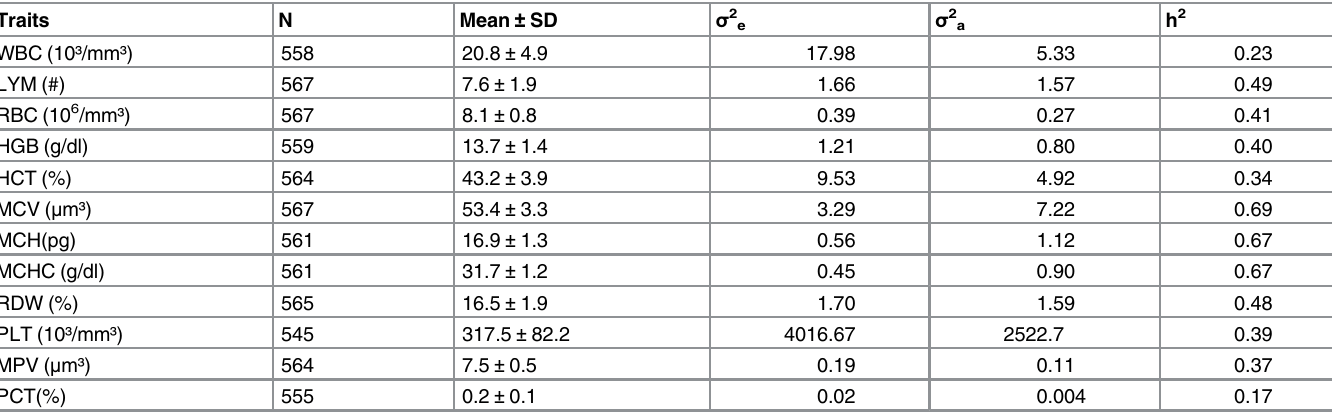
WBC, White blood cell count; LYM (#), Lymphocytes count, RBC, Red blood cell count; HGB, Haemoglobin concentration; HCT, Haematocrit level; MCV, Mean Corpuscular Volume; MCH, Mean Corpuscular Haemoglobin; MCHC, Mean Corpuscular Haemoglobin Concentration; RDW, Red Distribution Width; PLT, Platelets; MPV, Mean Platelet Volume; PCT, Plateletcrit;. σ 2 e , residual variance; σ 2 a , additive genetic variance; h 2 ,